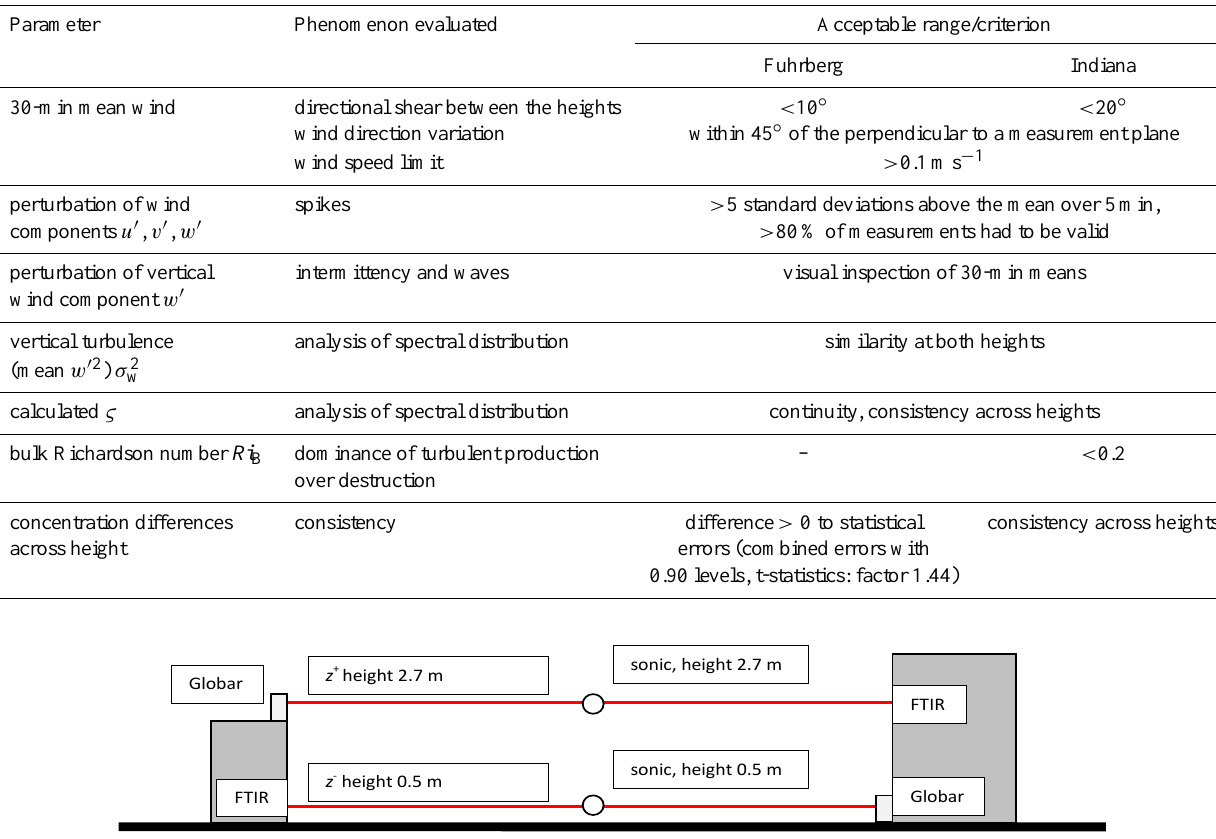
Table 1. Data which have been filtered at all heights for the quality-assured determinations of fluxes under low wind, stable or night-time atmospheric conditions and acceptable ranges for the various parameters.